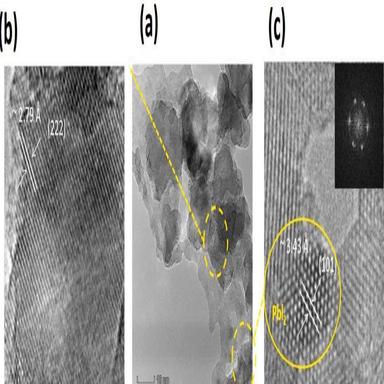
a) HRTEM image of MAPbI3 powder perovskite, b) the interplanar spacing of 2.79 Å corresponding to the (222) plane of the MAPbI 3 phase and c) the interplanar spacing of 3.43 Å corresponding to the (101) plane of the PbI2 secondary phase with its corresponding FFT image.